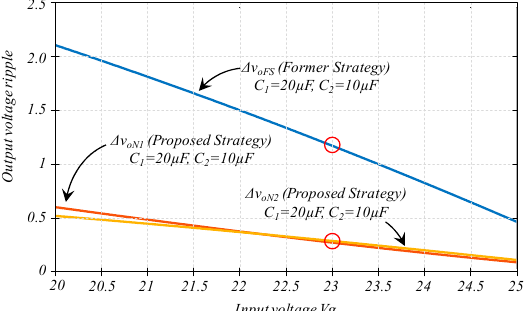
Figure 9. Output voltage ripple calculation for the full operation range with C1 = 20 µF and C2 = 10 µF, red circles indicate the operation point of the simulation shown in Figure 10.